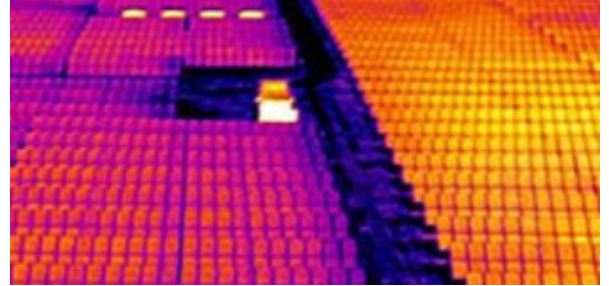
Figure 15. Wrong IR acquisition.